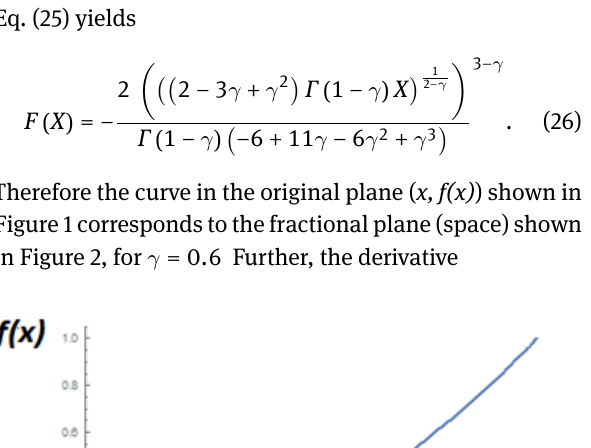
Recalling Eq. (25), the x 0 = 0.81 corresponding to X 0 = 0.60 is defined. Then substituting in the derivative dF ( X ) the fractional plane the X as a function of x , the Λ defined. Therefore the corresponding function in the